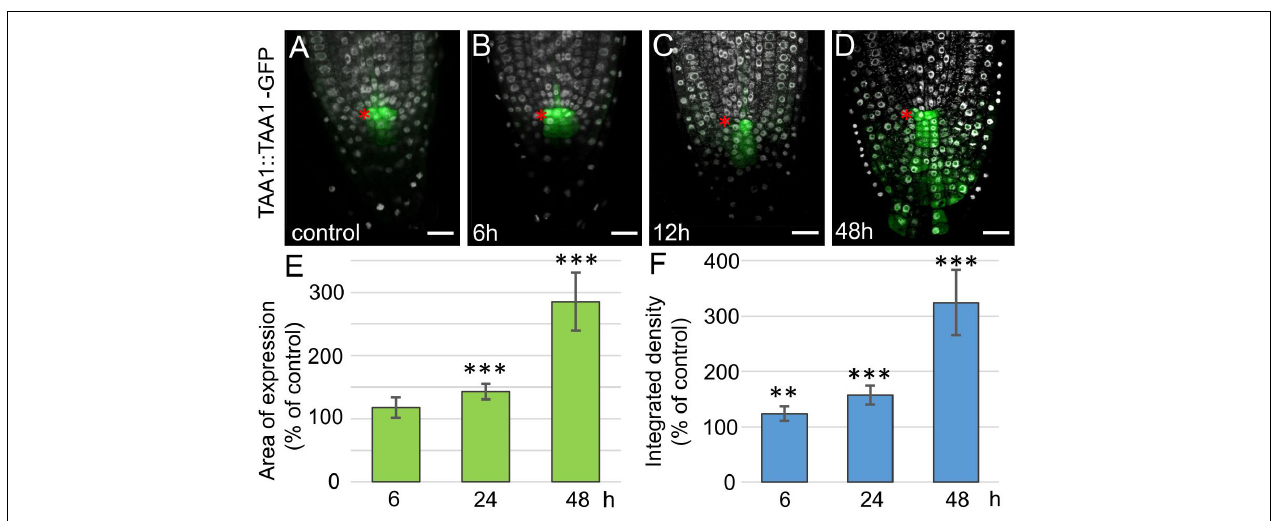
FIGURE 3 | Increase in TAA1 expression in 35S:WOX5-GR root tips during DEX exposure. (A–D) TAA1:TAA1-GFP expression at 0, 6, 12, and 48 h of DEX exposure (in green). DAPI is in white. The QC location is marked by the red asterisks. The bar scale – 20 µ m. (E,F) Statistics on the intensity of TAA1-GFP fluorescence level in 35S:WOX5-GR root tips after 6, 24, and 48 h of DEX exposure. The expression area (E) and the integrated density (F) of the fluorescent signal was measured using ImageJ (https://imagej.nih.gov/ij/docs/menus/analyze.html). The statistical significance of the differences relative to respected control, taken for each time point, was estimated using Welch’s t -test (** p < 0.01; *** p < 0.001; CI 95%, N =